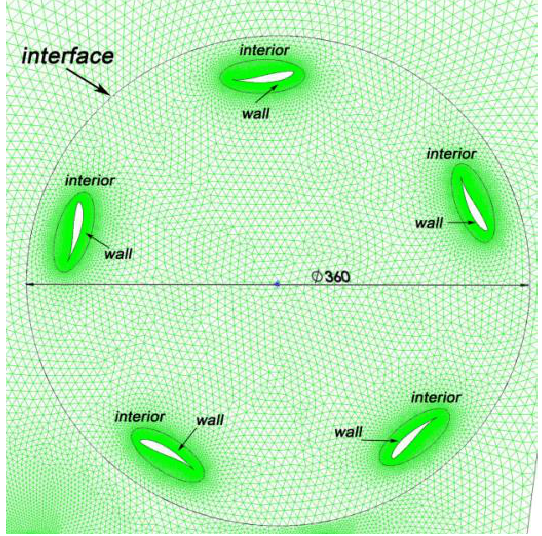
Figure 5. Mesh of rotating area